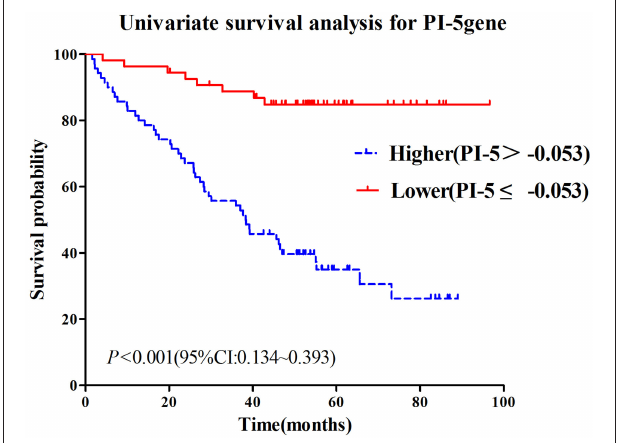
FIGURE 3 | Survival time and survival probability by tumor grade as defined using PI-5: high grade vs. low grade.